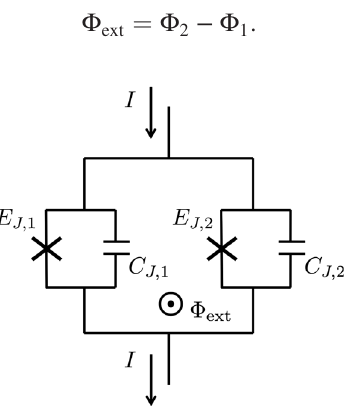
FIG. 9. Lumped-element description of a transmission line resonator terminated by a SQUID (adapted from Ref.